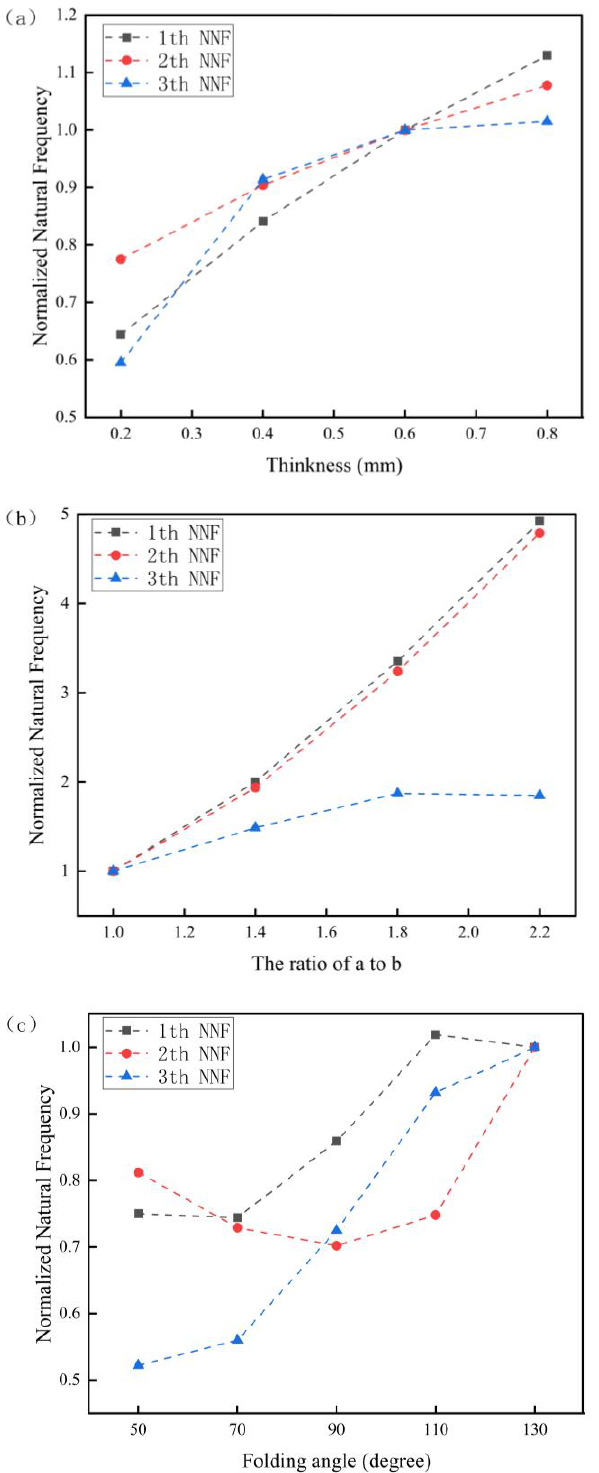
Figure 3. Numerical simulation results of the NF of the Miura tube. ( a ) NNF variation with wall thickness of the Miura tube ( b ). NNF variation with side length ratio of the Miura tube. ( c ) NNF variation with folding angle of the Miura tube.